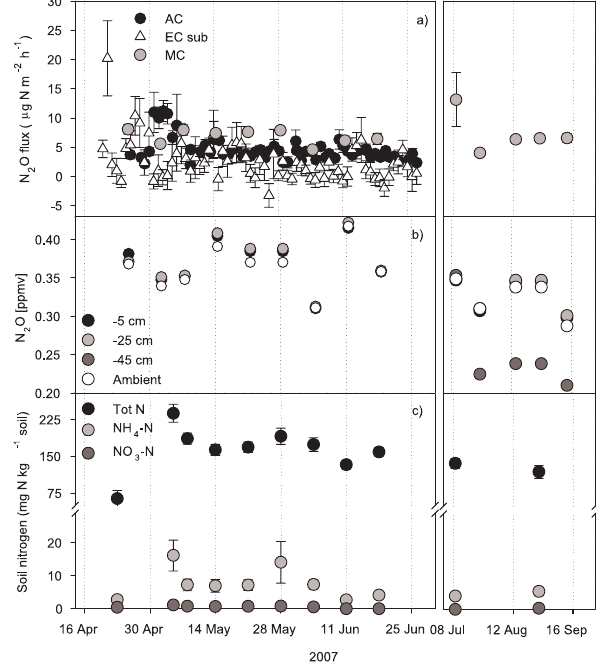
Fig. 6. (a) Mean soil N 2 O fluxes measured with eddy covariance, automatic and manual chambers, (b) soil concentrations of N 2 O at three depths and in the ambient air, and (c) mineral nitrogen and to- tal nitrogen concentrations in the litter layer of the soil during April– September 2007 at the drained peatland pine forest. First column of the figures represent the period of intensive measurements, the sec- ond shows the data outside the measurement campaign. Error bars stand for standard errors of the